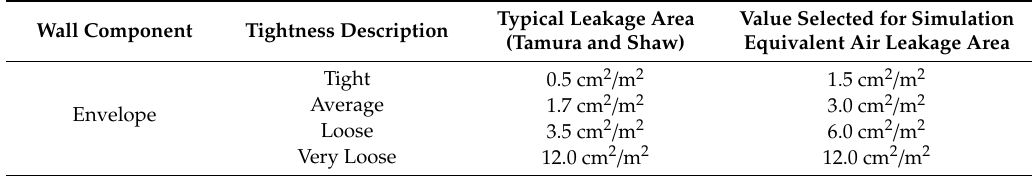
Table 1. Air leakage of